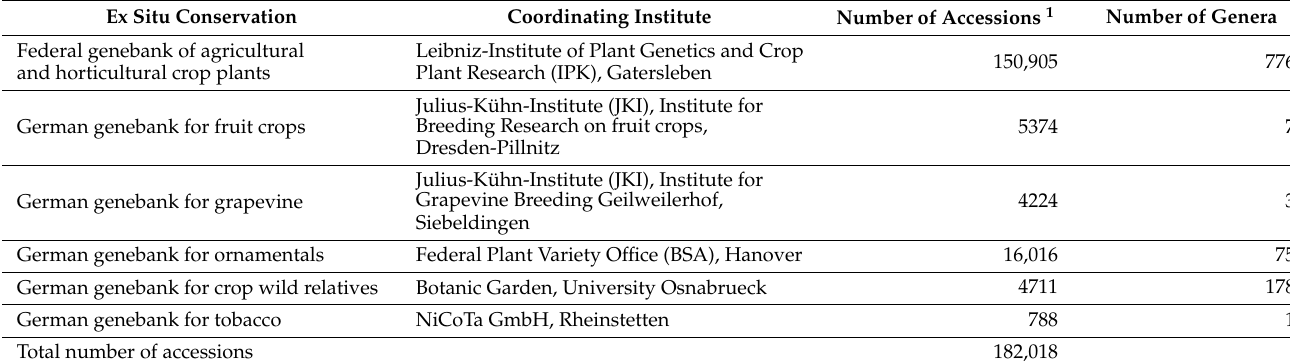
Table 3. Ex situ conservation of plant genetic resources in Germany